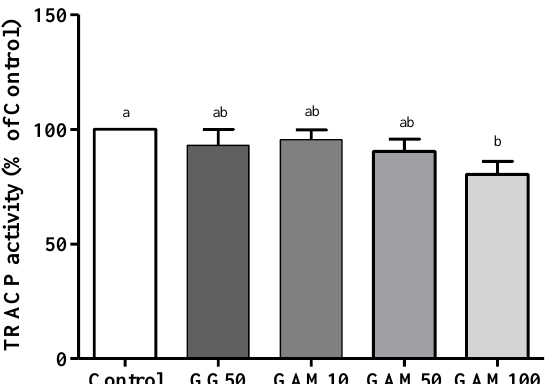
Figure 8. Effects of GAM on osteoclast differentiation in RAW264.7 cells. The effects of GAM on TRACP activity in RANKL-induced osteoclasts in RAW264.7 cells were evaluated using a TRACP activity assay kit. a,b Mean values with different letters differed significantly ( p < 0.05) among groups, as shown by Tukey’s test. Data are representative of at least three experiments.